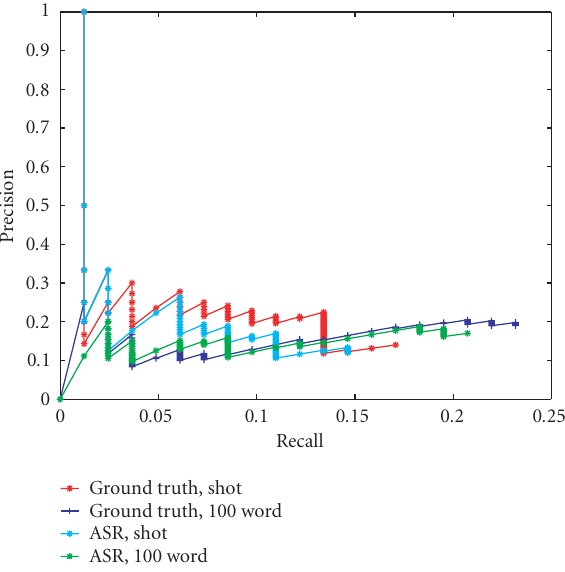
Figure 8: Precision-recall: human knowledge-based query.